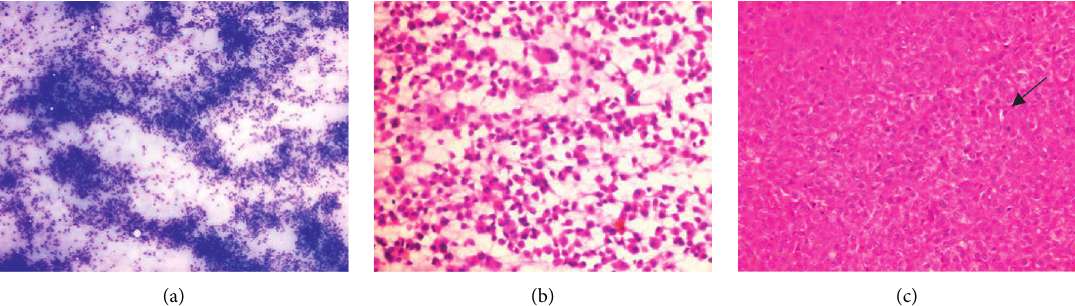
Figure 1: Malignant small round cell tumor (Ewing’s sarcoma). (a) Imprint smear showing sheets of small round to oval tumor cells showing moderate atypia. Cytoplasm is vacuolated (H&E, X400). (b) Scrape smear showing sheets and singly scattered malignant small round tumor cells (MGG stain, X200). (c) Paraffin-embedded section showing malignant small round tumor cells arranged in sheets with coarse nuclear chromatin and scant cytoplasm. Mitotic figures are also seen (arrow) (H&E, X400).